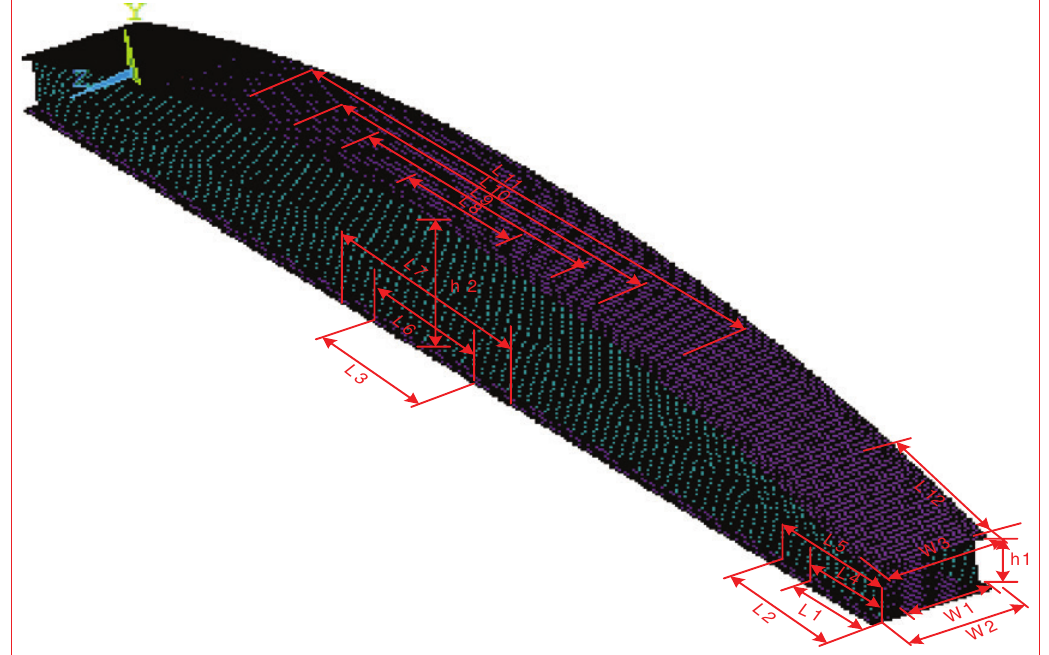
Figure 5: The initial optimum design parameters and their